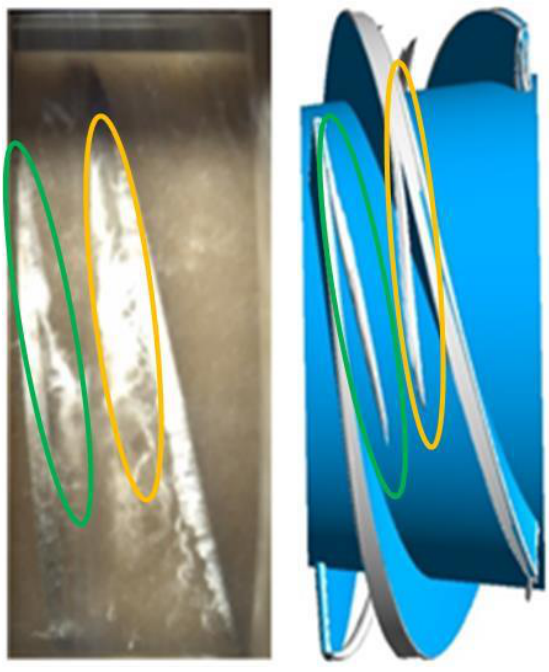
Figure 5. CFD and experimental flow fields.